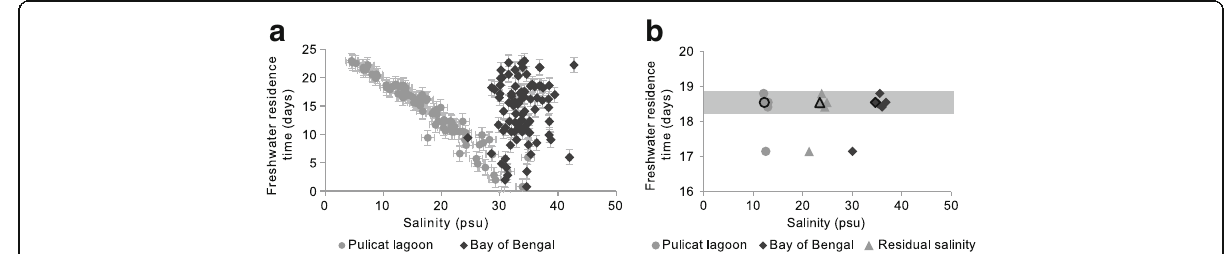
Fig. 7 The values of the system salinity (Pulicat lagoon) as well as the sea salinity (Bay of Bengal) obtained as 100 realisations of the variables using Monte-Carlo simulations derived using the budget tool developed by Swaney and Hong (2009b). a Gamma distributions of the modelled salinities between the two exchanging systems and the corresponding changes in the freshwater residence times within Pulicat system. b Maximum likelihood estimates and modelled salinities closest to in situ measurements of surface salinities in the lagoon and the sea (outlined points) are shown versus their freshwater residence